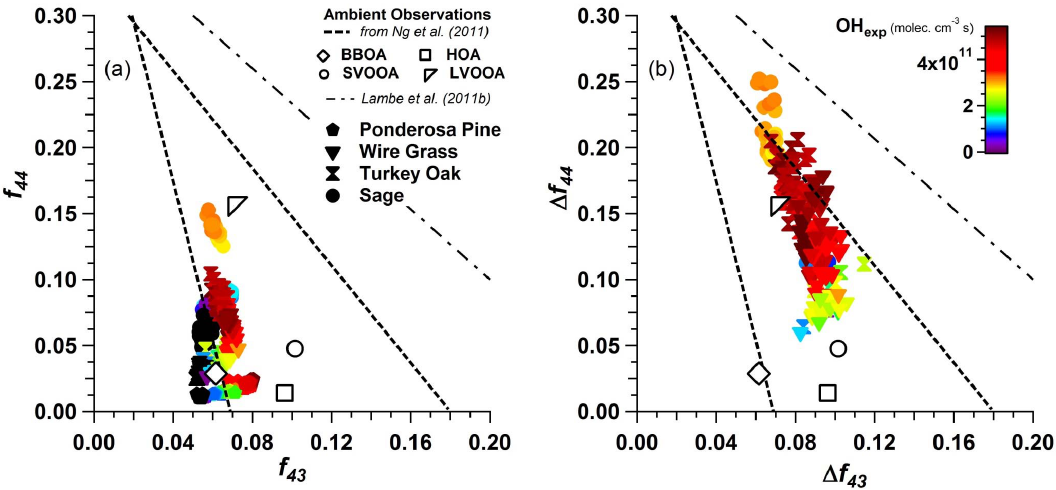
Fig. 11. Aging effect on oxidation and SOA markers. (a) f 44 vs. f 43 from four fuels. The window of observed ambient OOA is within the black dotted lines (Ng et al., 2010), and the window of the flow-reactor-observed values is within the dash-dotted lines (Lambe et al., 2011b). (b) Change in f 44 and f 43 due only to added SOA mass, where 1f 44 is plotted with respect to 1f 43 . In both plots, all fuels are colored by OH exposure with maximum at 5.38 × 10 11 moleculescm − 3 s. Ambient multistudy average BBOA, HOA, SVOOA, and LVOOA factors are shown for reference from Ng et al.